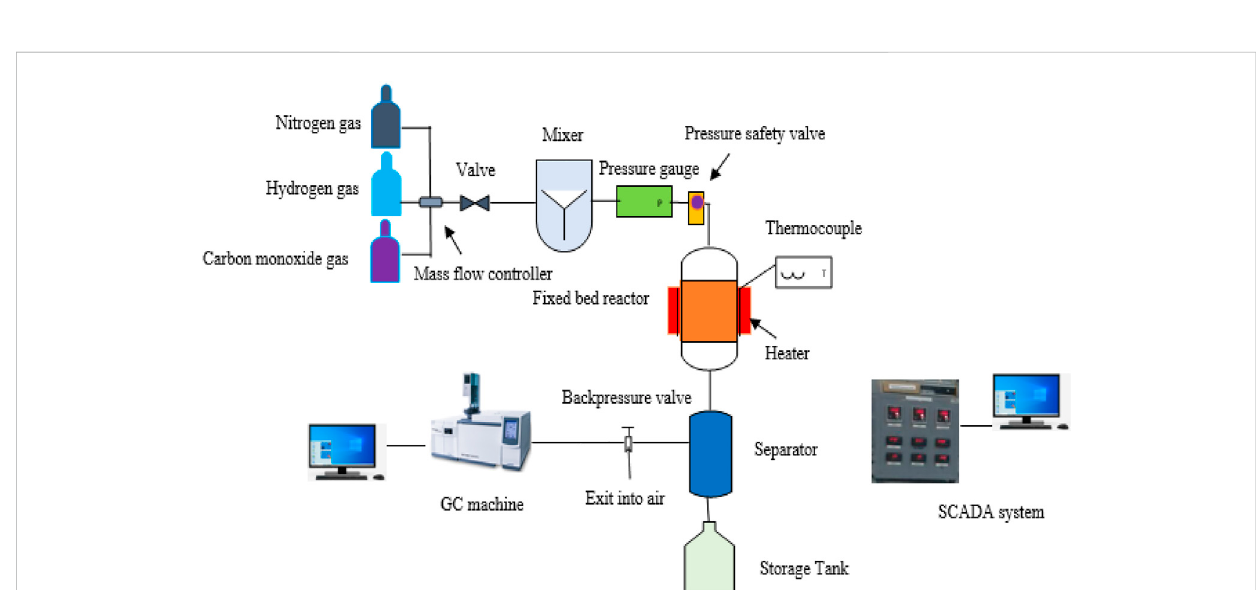
FIGURE 2 Schematic diagram of the fi scher tropsch synthesis